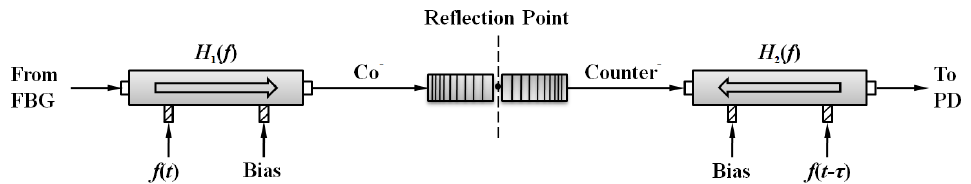
Figure 2. Equivalent model of bidirectional modulation with a MZ-EOM and a